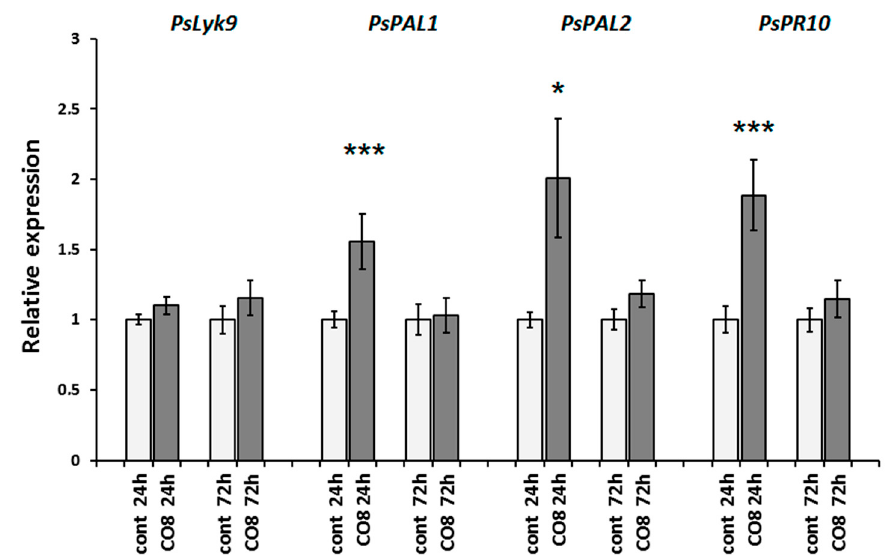
Figure 3. Transcript levels of the PsLyk9 gene encoding LysM-RLK and PsPAL1 , PsPAL2 , PsPR10 defense-response genes in pea roots treated with 10 − 6 M CO8 for 24 and 72 h. As a control, water-treated plants were used. The relative expression was normalized against the constitutively expressed ubiquitin and actin genes. Values are means ± SEM of three technical repeats. The graphs show the results of one biological repeat, representative for three biological independent experiments. Asterisks indicate statistically significant differences compared with the respective water-treated control: *** p < 0.001, * p < 0.05.